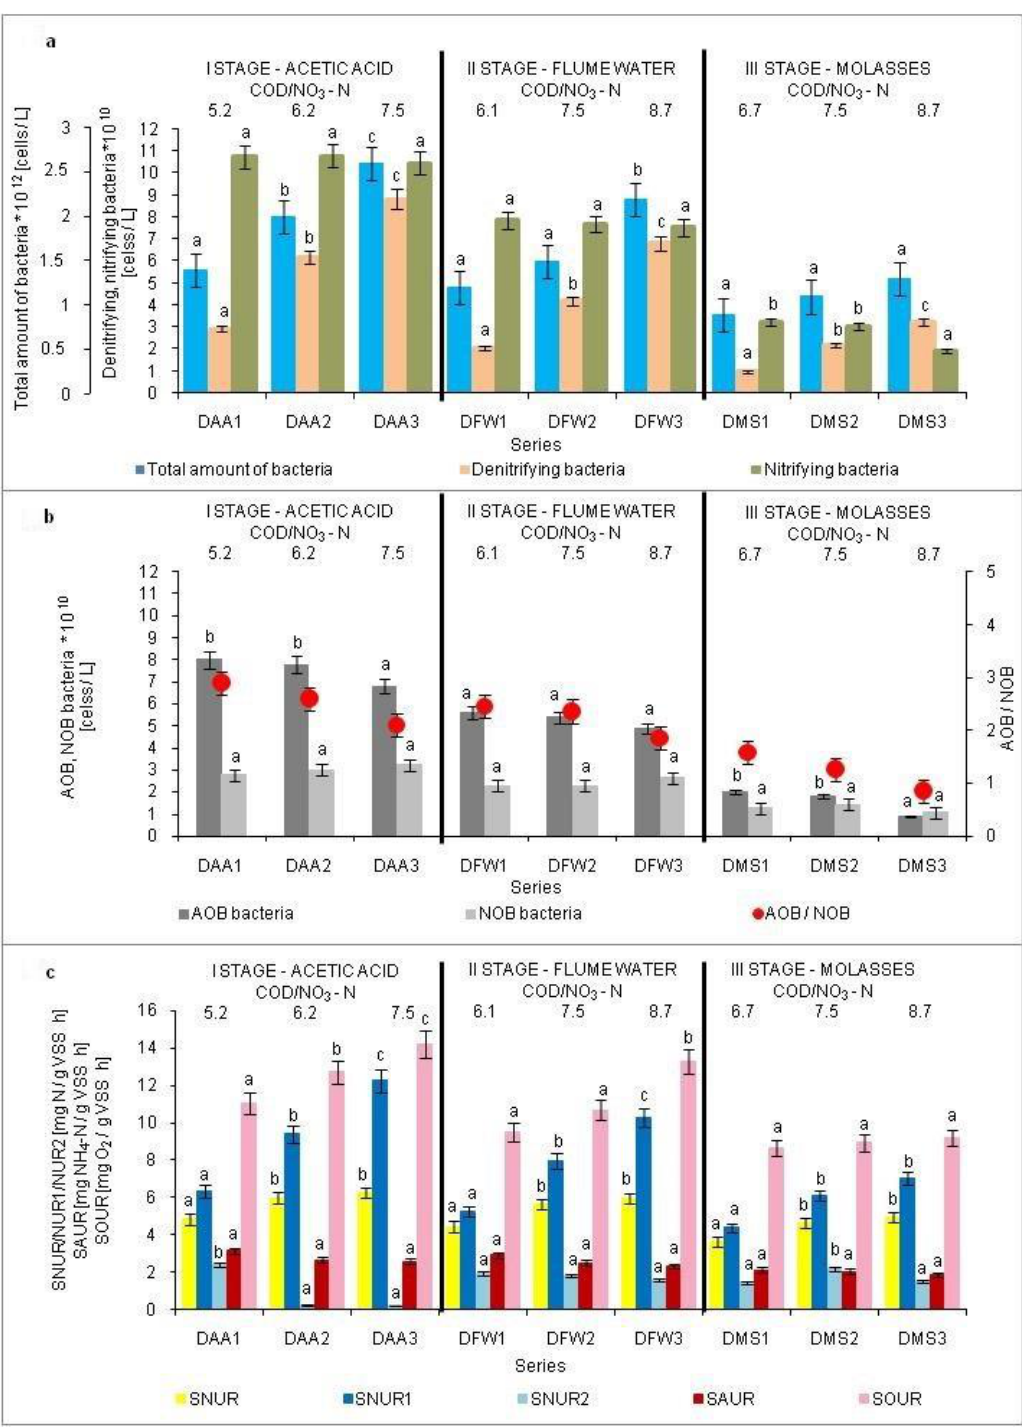
Figure 3. The amount ( a , b ) and activity ( c ) of bacteria in the activated sludge depending on the type of external carbon source and the COD/NO 3 – N ratio. Means (n = 3) within each kind of bacteria and each batch test and each kind of external carbon source followed by the same letter are not statistically different according to Tukey’s test.